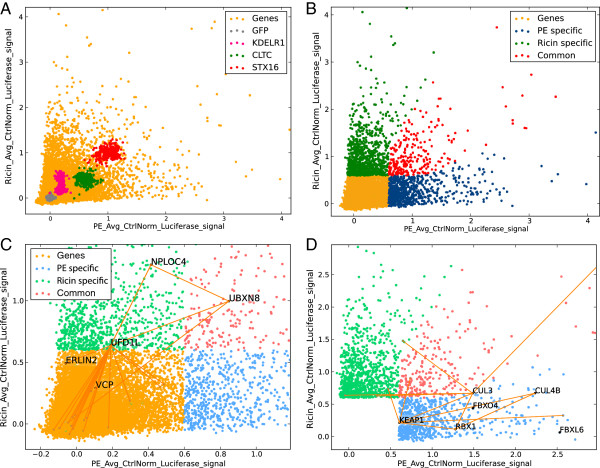
Screen comparison. (A) Scatter plot of average control-normalized luciferase signals of PE vs Ricin, with controls highlighted. (B) Scatter plot of average control-normalized luciferase signals of PE vs Ricin, color-coded according to toxin-specificity. (C) ERAD protein-protein interaction network displaying Ricin specificity, demonstrating the identification of a gene below but close to the chosen threshold (ERLIN2), and a potential false negative gene (VCP). (D) Cullin-Ring Ligase complex protein-protein interaction network displaying PE specificity.